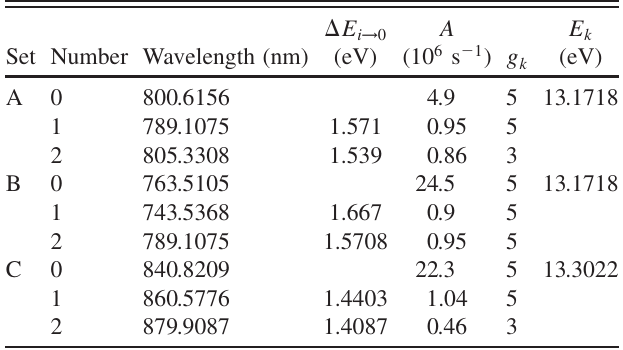
TABLE I. Data of argon line sets.